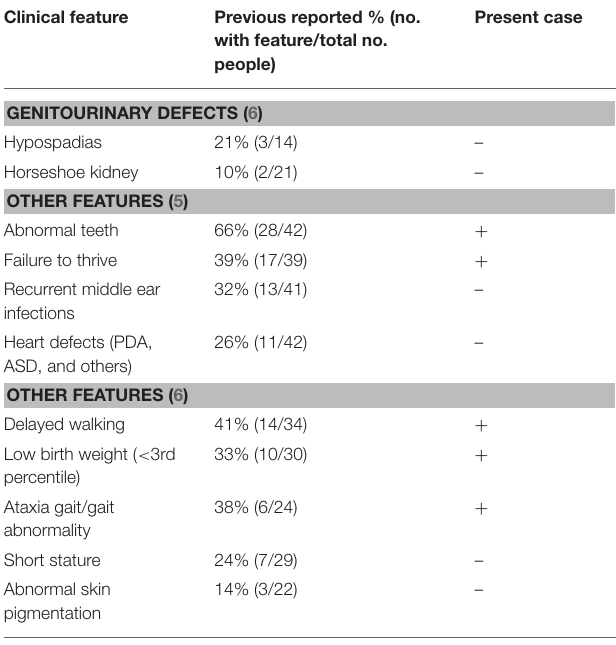
TABLE 1 | Clinical presentation of patient in comparison to phenotypic features, reported in a registry for 3q29 deletion (5) or by the literature review from Cox and Butler (6), arranged by decreasing frequency. Previous reported % (no.